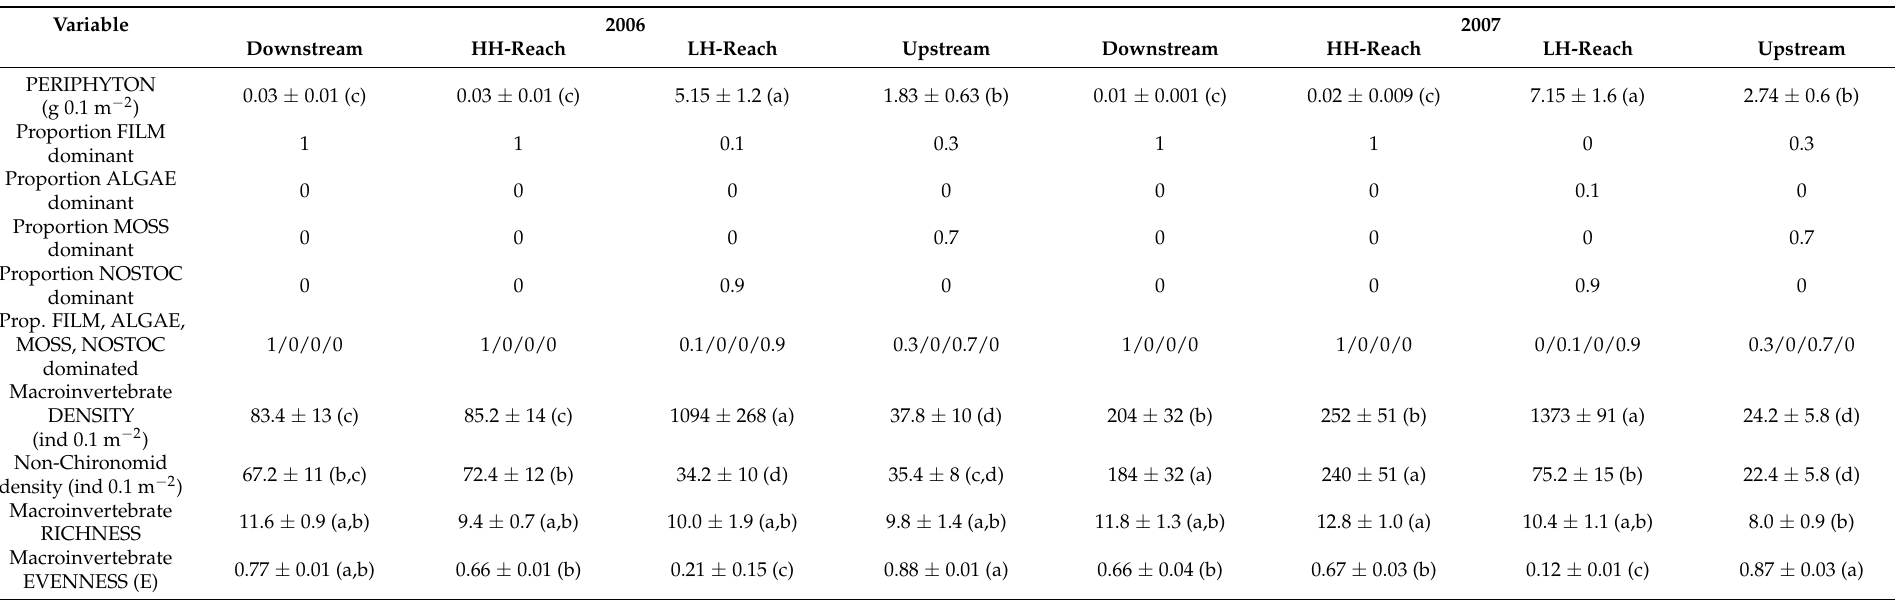
Table 2. Biotic results by year of sampling and reach. For quantitative variables, values reported are mean ± S.E. Groups with the same letter (i.e., a–d) are not significantly different ( α = 0.05) according to Duncan’s Multiple Range Test. For categorical variables, the proportion of transects in each categorical level is reported by group. Variable names are